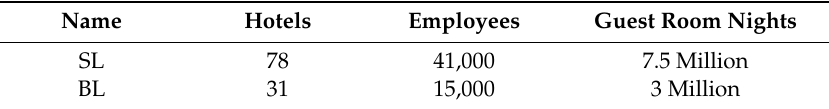
Table 2. Company demographics (taken from corporate websites).